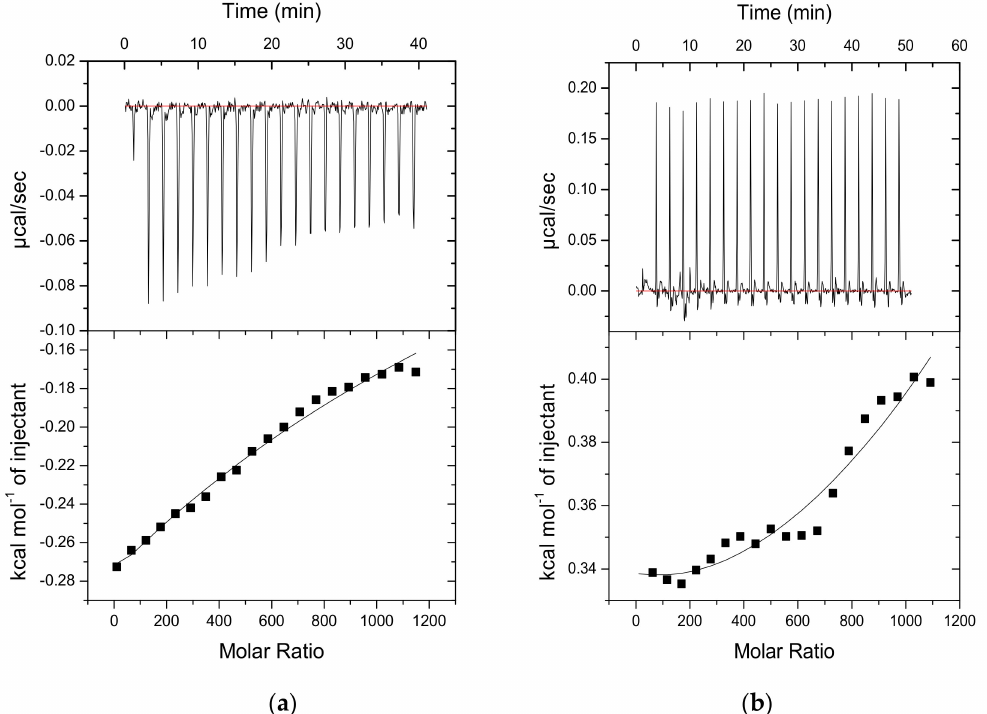
Figure 5. The isothermal titration calorimetric analysis of the binding of angiotensin-converting enzyme (ACE) at a concentration of 357 nm to the substrate HHL at a concentration of 1mM without any inhibitor (Figure 5a ) or with Belpep as inhibitor at a concentration of 0.5mM (Figure 5b ). The upper panel shows a typical ITC curve, showing the heat release as a function of time depicted in the thermogram for binding of the ligand and the enzyme at pH 8.3 and temperature 37 ◦ C, whereas the lower panel of the figure shows the isotherm depicting the integrated heat evolved per mole of the inhibitor for addition of each injection with respect to the total molar ratio of the ligand over the enzyme